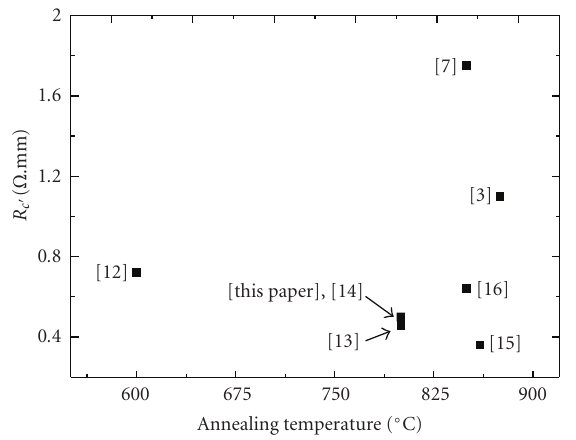
Figure 4: Comparison of Ohmic contact resistance, R C , on AlN/ GaN-based devices as a function of annealing temperatures from various publications.